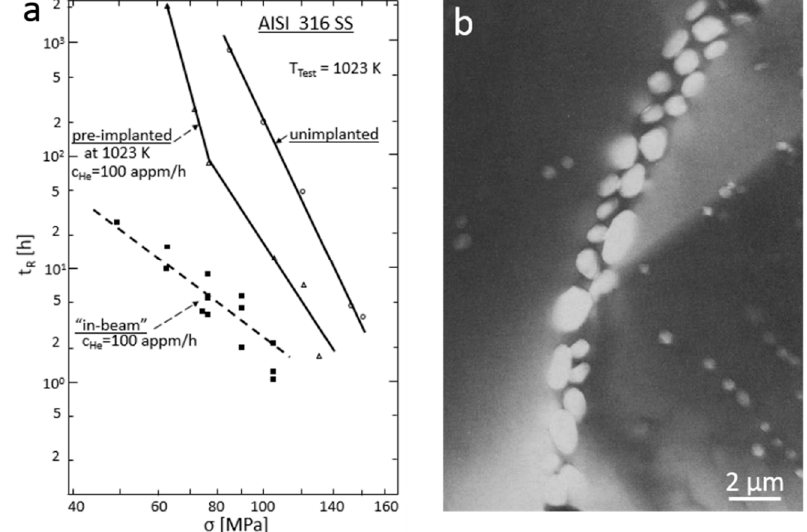
Figure 20. ( a ) The dependence of creep rupture time on creep stress of 316 SS at 1023 K with different irradiation parameters; and ( b ) large He bubbles distributed along GB, which is perpendicular to the applied stress after creep test. Reprinted with permission from [141]; Copyright 1983 Elsevier.